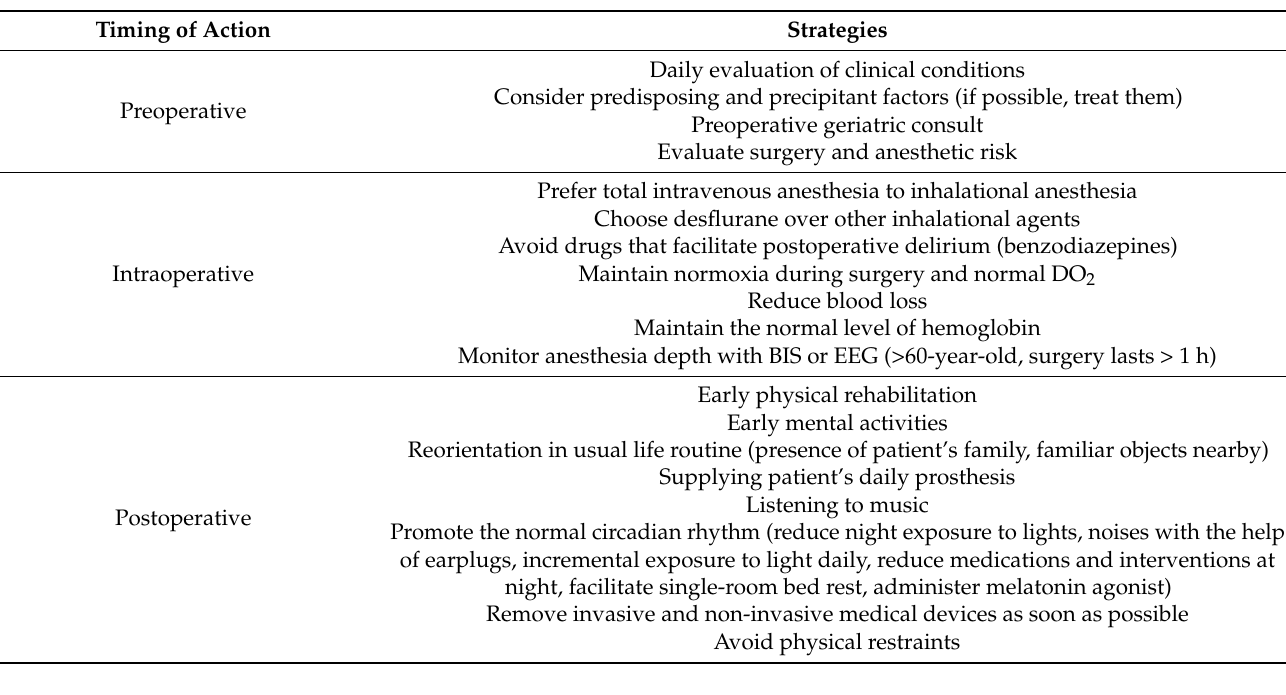
Table 2. Strategies to avoid or reduce